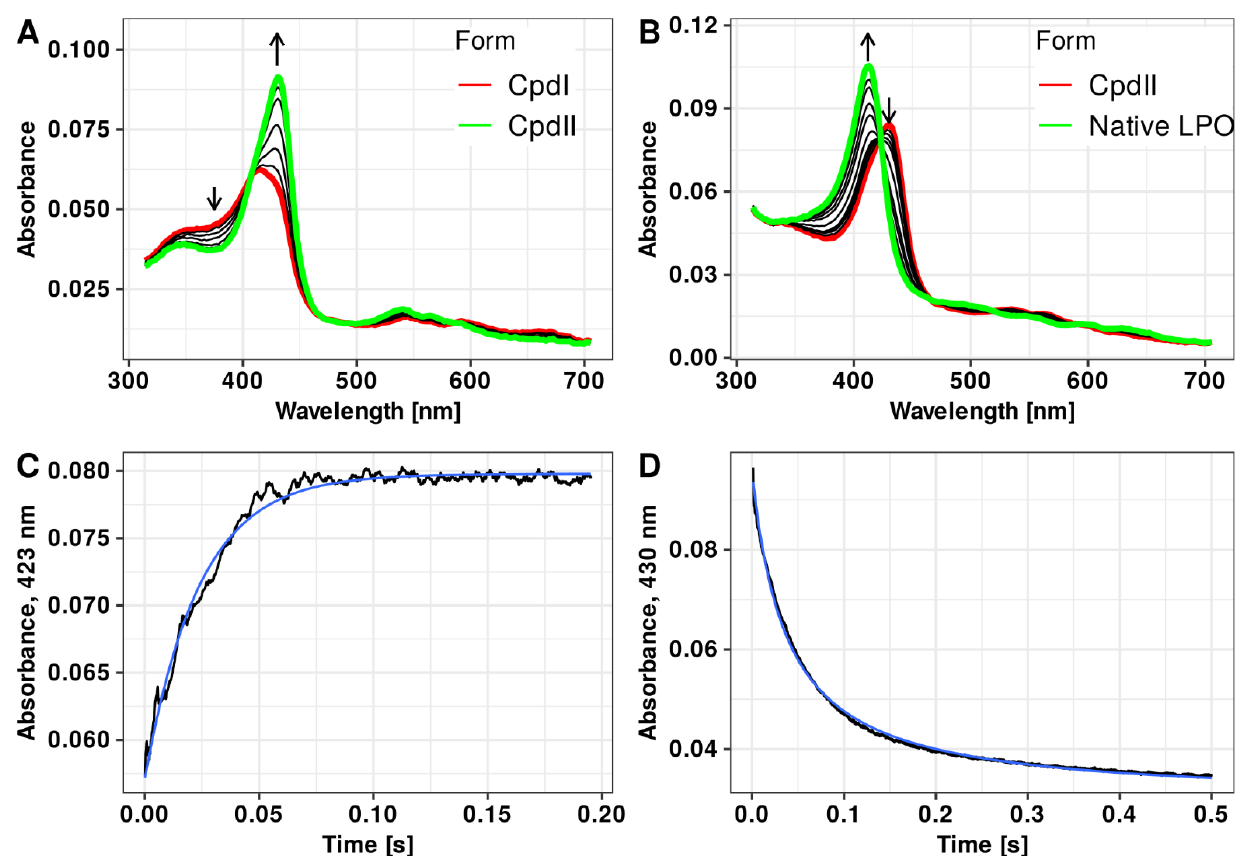
Figure 4. ( A ): Spectral changes accompanying the spontaneous generation of Compound II from Compound I. First spectrum (red) was obtained 200 ms after mixing LPO with hydrogen peroxide and corresponds to Compound I. Last spectrum (green) was registered after 5 s of incubation; complete generation of Compound II can be observed. ( B ): After addition of organic substrates, rapid reduction of Compound II (red) to native LPO (green) is observed. Typical kinetic trace reflecting the reaction between (-)-epicatechin and Compound I or Compound II with exponential fit (blue line) is shown at ( C ) and ( D ), respectively. Experimental conditions: 15°C; ( A , C ) LPO 1 µM, H 2 O 2 1 µM; ( B , D ) LPO 1 µM, H 2 O 2 0.75 µM, (-)-epicatechin 7 µM.